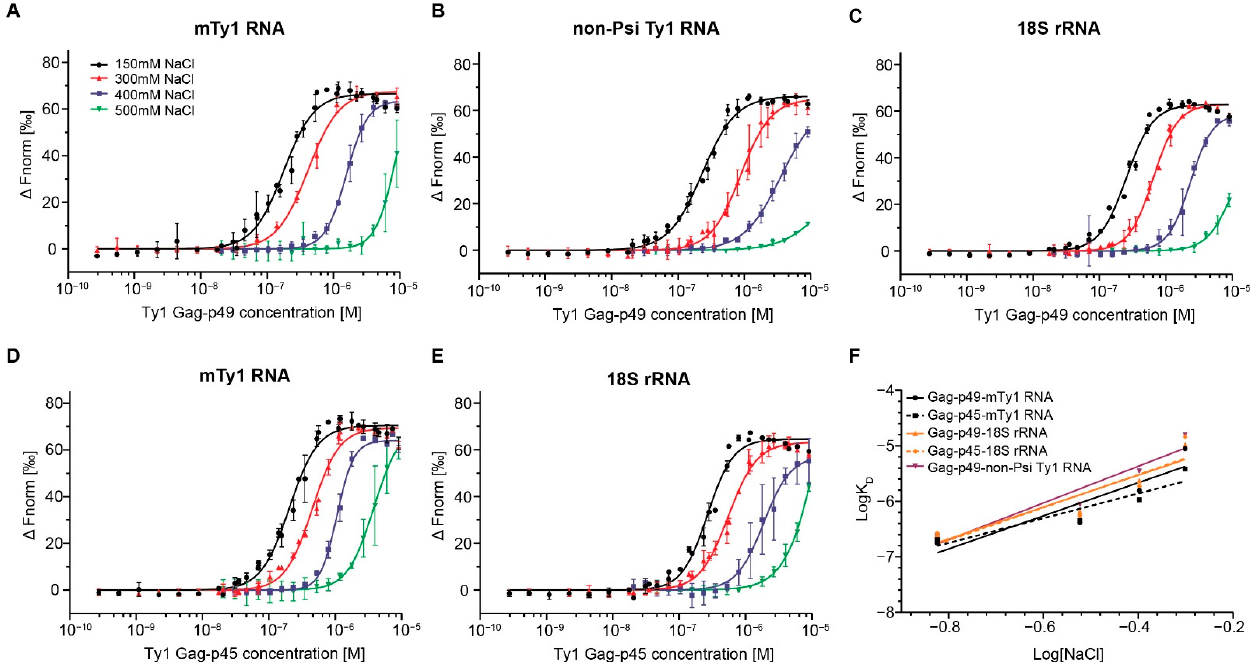
Figure 2. MST analysis of Ty1 Gag ‐ RNA interactions at increasing ionic strength. Dose–response binding curves of Ty1 Gag ‐ p49 to mTy1 RNA ( A ), non ‐ Psi Ty1 RNA ( B ), 18S rRNA ( C ) and of Ty1 Gag ‐ p45 to mTy1 RNA ( D ) and 18S rRNA ( E ) at 150, 300, 400 and 500 mM NaCl. Lines represent fits of the data points using the Hill equation (EC50). ( F ) The log ‐ log plot of the binding affinity as a function of NaCl concentration for Ty1 Gag ‐ p49 (solid lines) and Ty1 Gag ‐ p45 (dashed